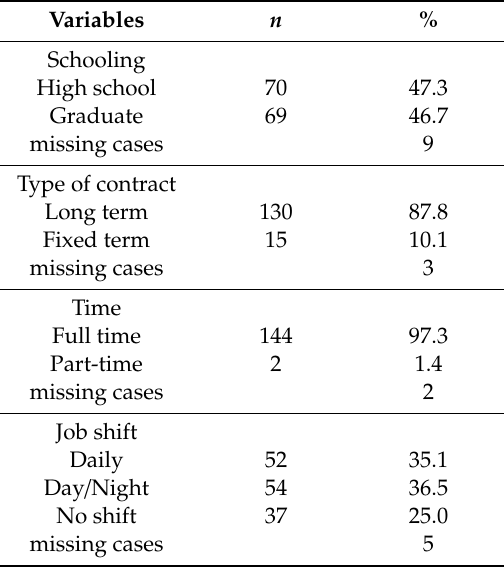
Table 1. Sample characteristics ( n =